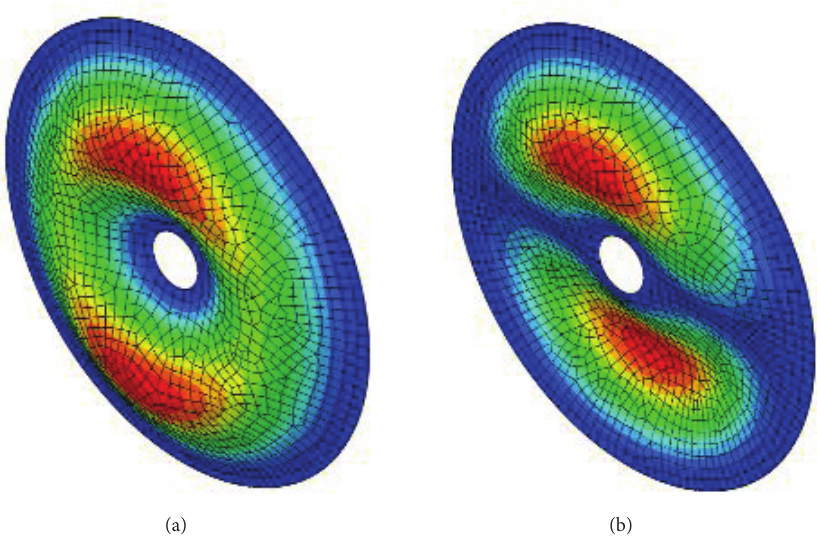
Figure 2: Mode shapes associated with (a) first and (b) second modes of vibration of an annular plate.